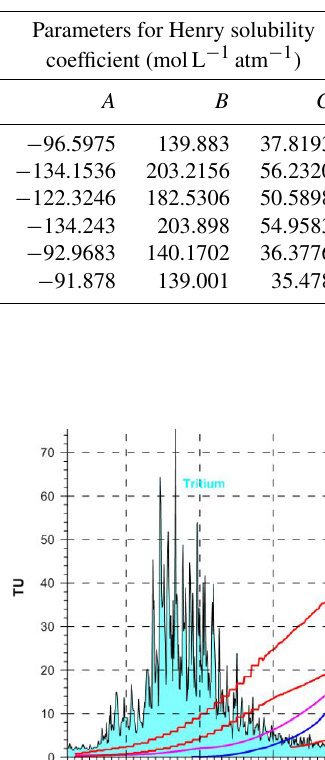
usually contained in air ∗ Estimated from atmospheric concentration at time of filling. Table 3. Reported solubility parameters for Halon-1301 and SF 6 and (*) solubility parameters for Halon-1301 estimated in Beyer et al. (2015) with an uncertainty of 10%.